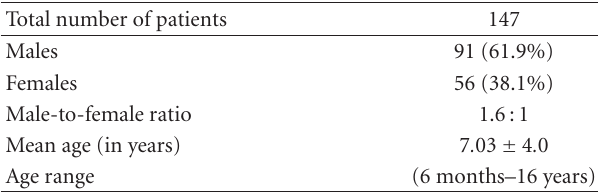
Table 1: Patient characteristics.